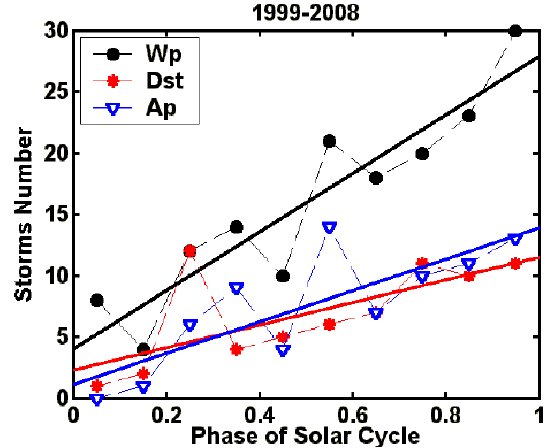
Fig. 3. Solar cycle trend of the number of magnetospheric